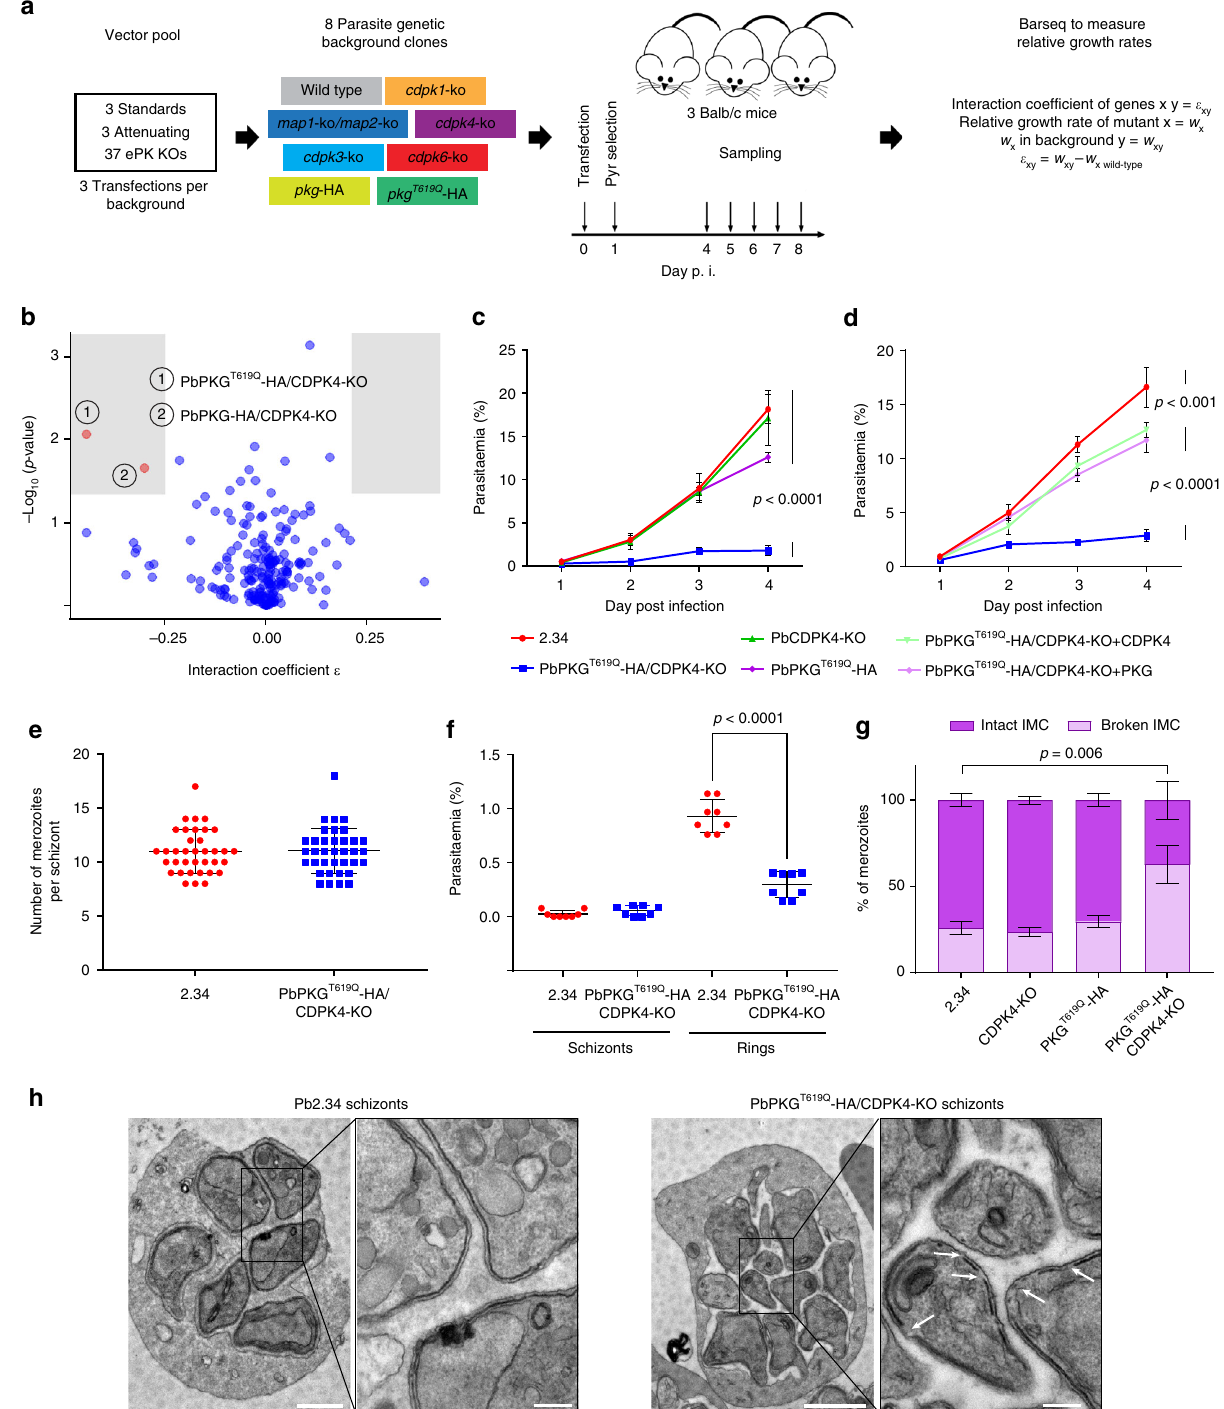
Barseq to measure relative growth